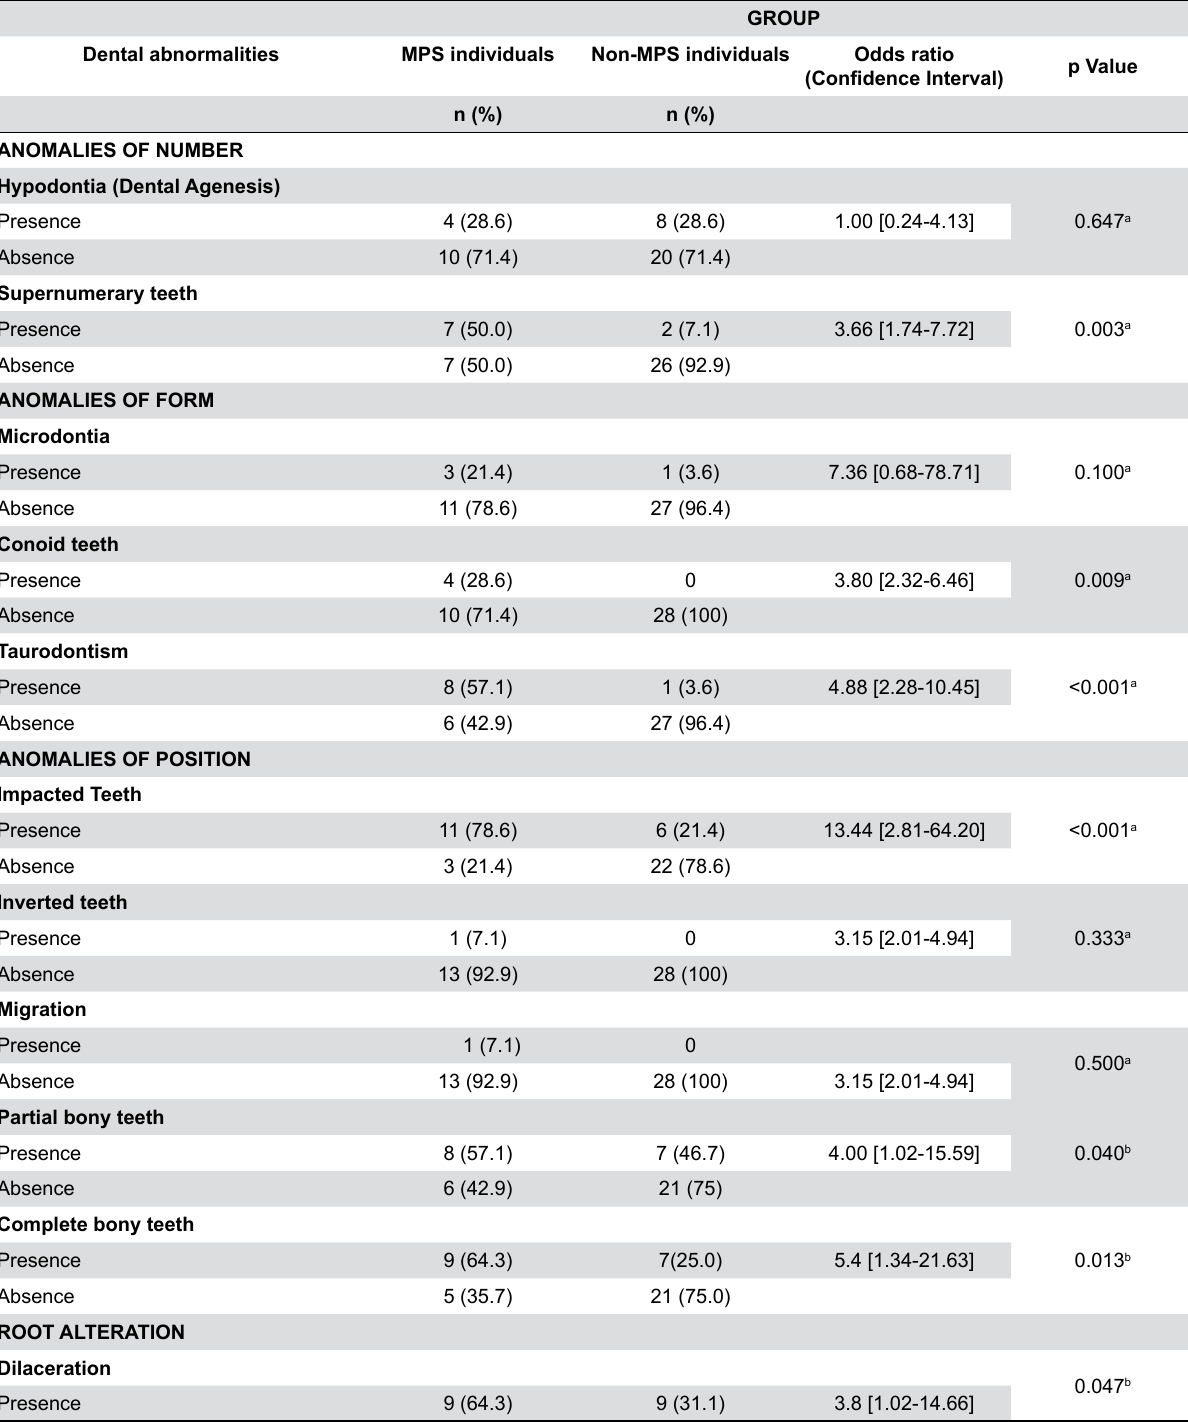
Table 1- Comparative radiographic analysis of the presence of dental anomalies between MPS and non-MPS individuals